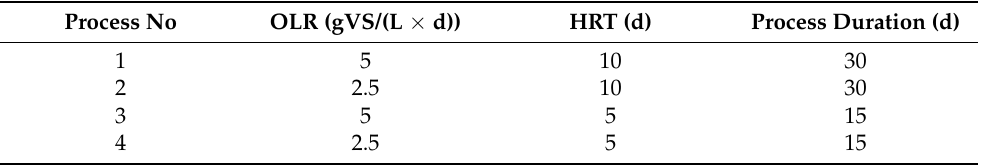
Table 3. Conditions of the performed DF